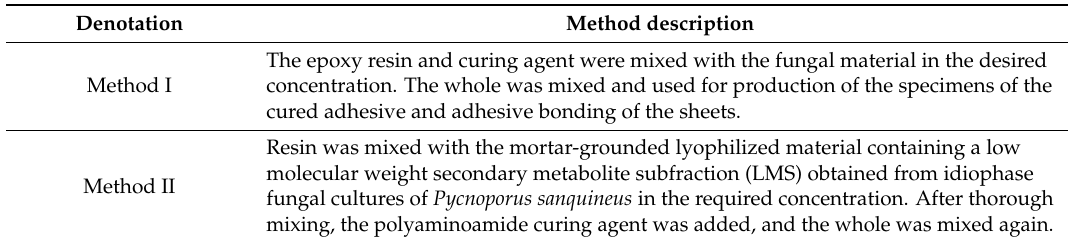
Table 2. Methods for preparation of the adhesive compound.